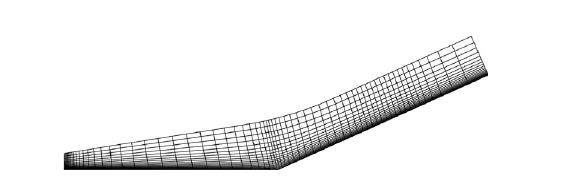
Figure 1: Grid diagrammatic sketch for ramp